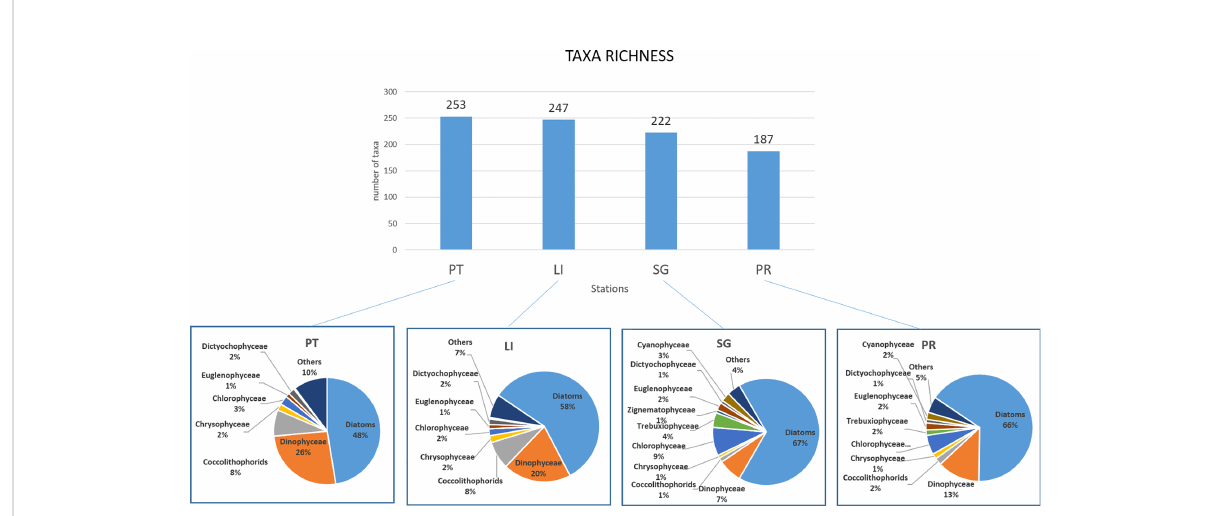
FIGURE 5 Number of species and mean contribution of the main phytoplankton taxa at each sampling station. St. PT, Platform station; ST LI, Lido station; St. SG, San Giuliano station; St. PR, Palude della Rosa station.